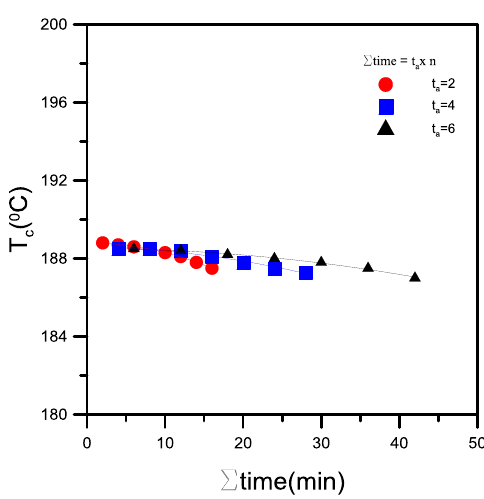
Figure 11. Effect of the Σ t a on T c for the phenoxy/PBT = 1/9 sample.